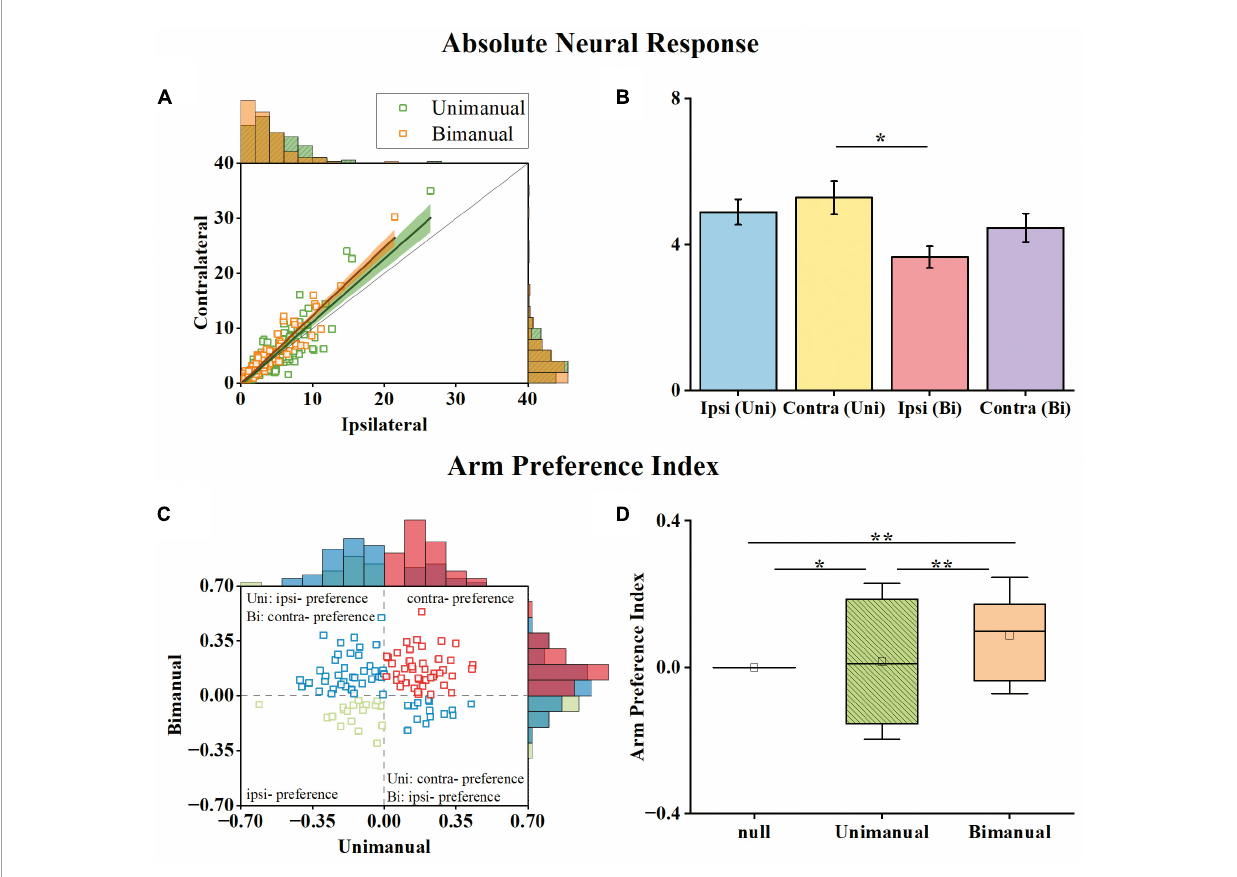
FIGURE4 M1 units had similar neural responses for the ipsilateral and contralateral arm movements in the unimanual task but changed to prefer the contralateral arm in the bimanual task. (A) Scatter plot of the maximum absolute responses of the neurons during the ipsilateral versus contralateral arm movements. The blue squares plot the 117 3-task-related neurons in the unimanual task. The lines with the shaded regions represent the best fit line and 95% confidence interval for unimanual ( y = 1.15x–0.34, R 2 = 0.77; green) and bimanual ( y = 1.24x–0.08, R 2 = 0.88; orange) movements. (B) Means of the maximum absolute responses for the unimanual ipsilateral (blue), unimanual contralateral (yellow), bimanual ipsilateral (red), and bimanual contralateral movements (purple). Bars and error bars depict the means ± SD. (C) Scatter plot and histogram of the arm preference index of the neurons during the unimanual versus bimanual arm movements. Each square represents a single neuron. (D) Boxplots of the median, the 25th, and 75th percentiles of the contralateral arm preference index for the data in panel (C) . The squares represent the mean. Error bars indicate the SD. * p < 0.05, ** p < 0.01, t